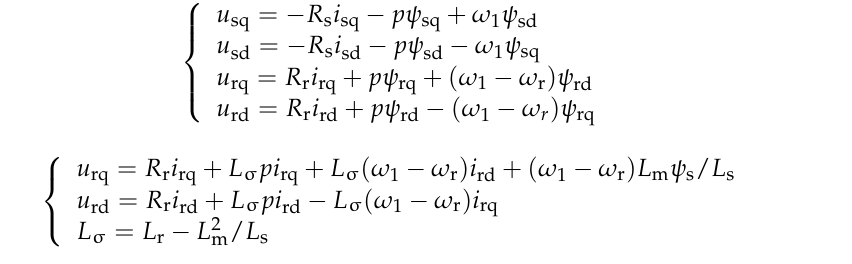
where u sq , u sd , i sq , i sd , u rq , u rd , i rq , and i rd are the voltages and currents of the stator and rotor q,d-axis component, respectively; ψ sq , ψ sd , ψ rq , and ψ rd are the flux linkages of the stator and rotor q,d-axis component, respectively; R s and R r are the resistance of the stator and rotor, respectively; ω 1 and ω r are the synchronous rotating angular velocity and